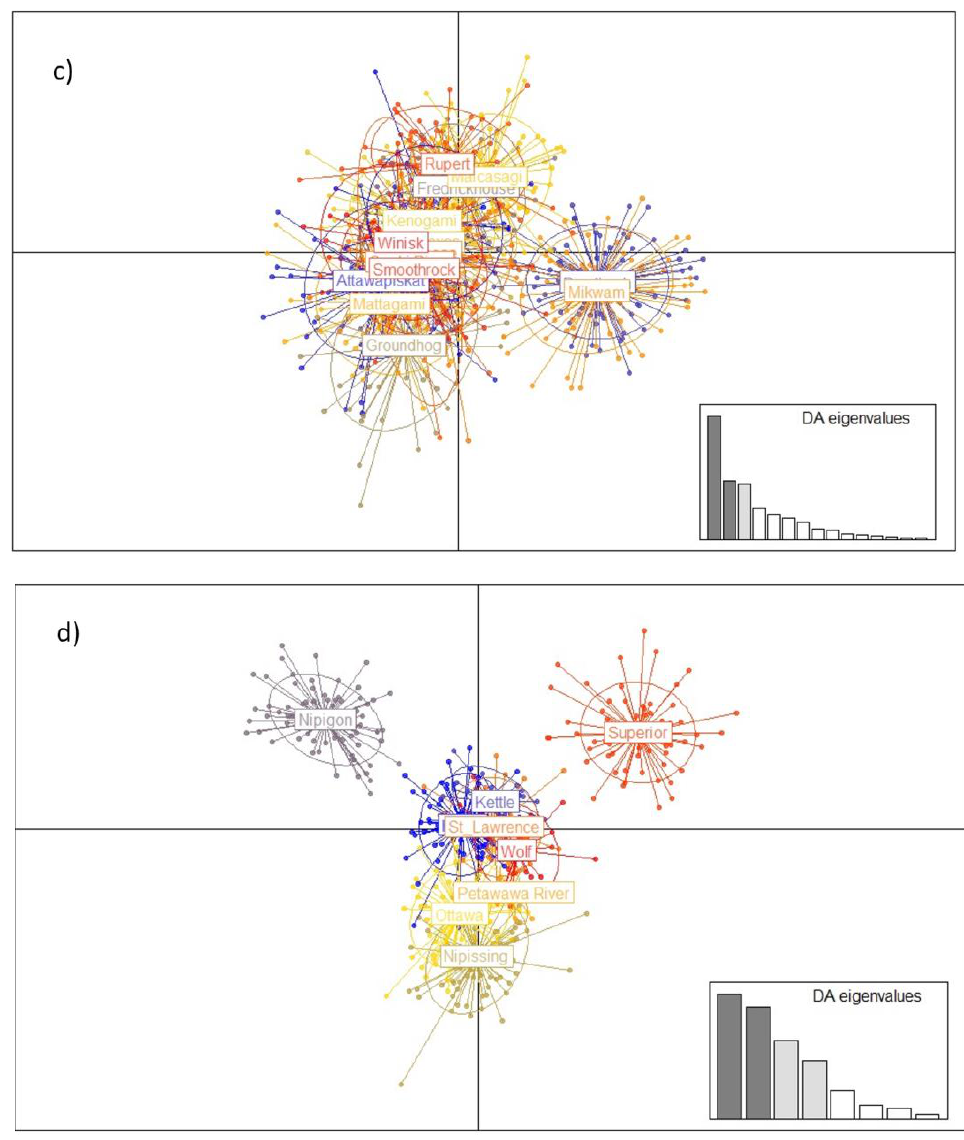
Figure 3. Discriminant Analysis of Principal Components (DAPC) of lake sturgeon across the species range, ( a ) grouped by major watershed (“GL/SL” = Great Lakes/St. Lawrence River), and ( b – d ) for geographically distinct subgroups. ( b ) Saskatchewan – Nelson River watershed; ( c ) Hudson Bay watershed; ( d ) Great Lakes/St. Lawrence watershed. For drainage basins with large numbers of samples (groups in ( a ) and large populations in ( b – d )), a random subsample of 100 genotypes was used to avoid biasing ordination outcomes from unequal sample sizes. Inset plots show significant axes and weighting of discriminant analysis eigenvalues.